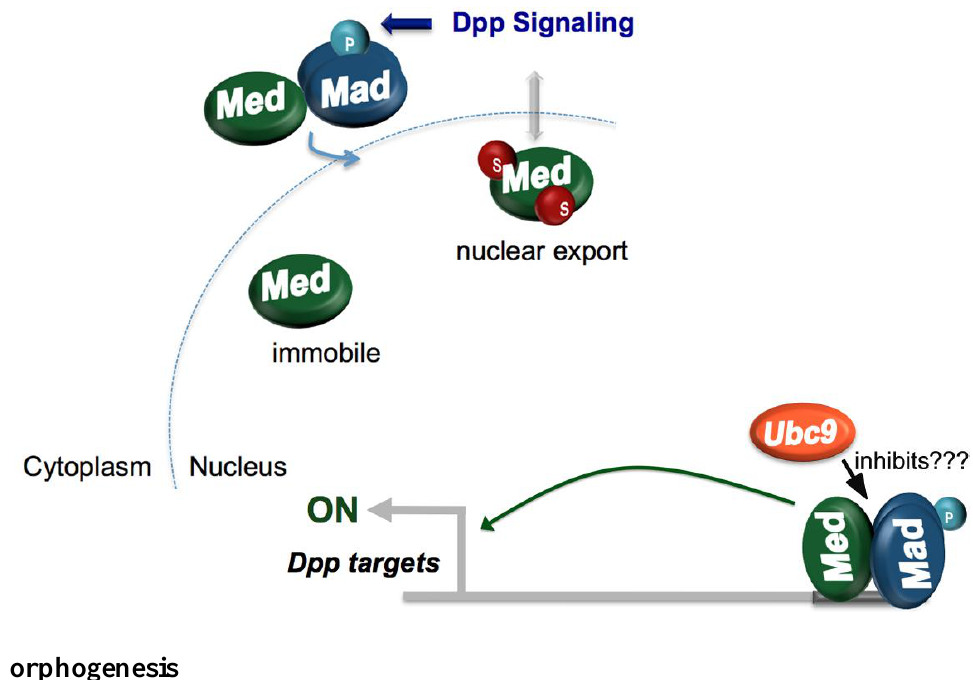
Figure 2. Med SUMOylation limits Dpp signaling by stimulating Med nuclear